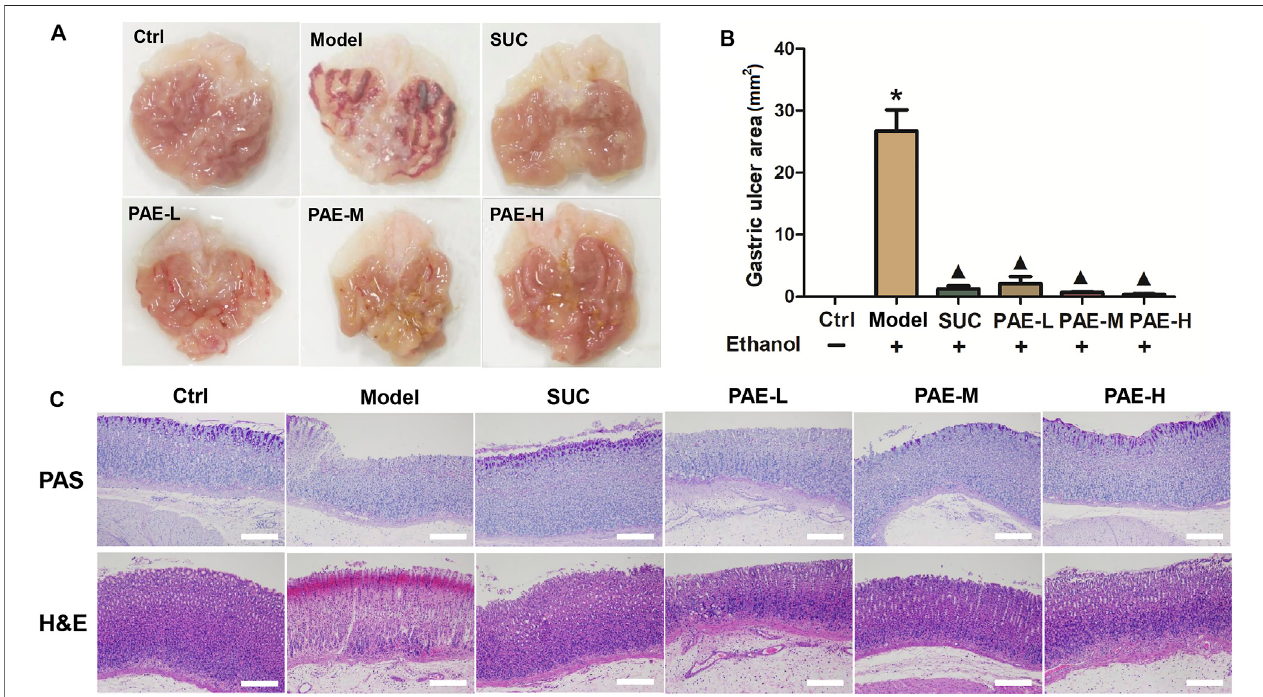
FIGURE5| EffectofPAE onthe levels ofMPOand SODin ethanol-stimulated gastric tissues. * p < 0.05, Ctrlgroup vs. Gastric ulcer model group; ▲ p < 0.05, PAE/ SUC treatment group vs. Gastric ulcer model group.